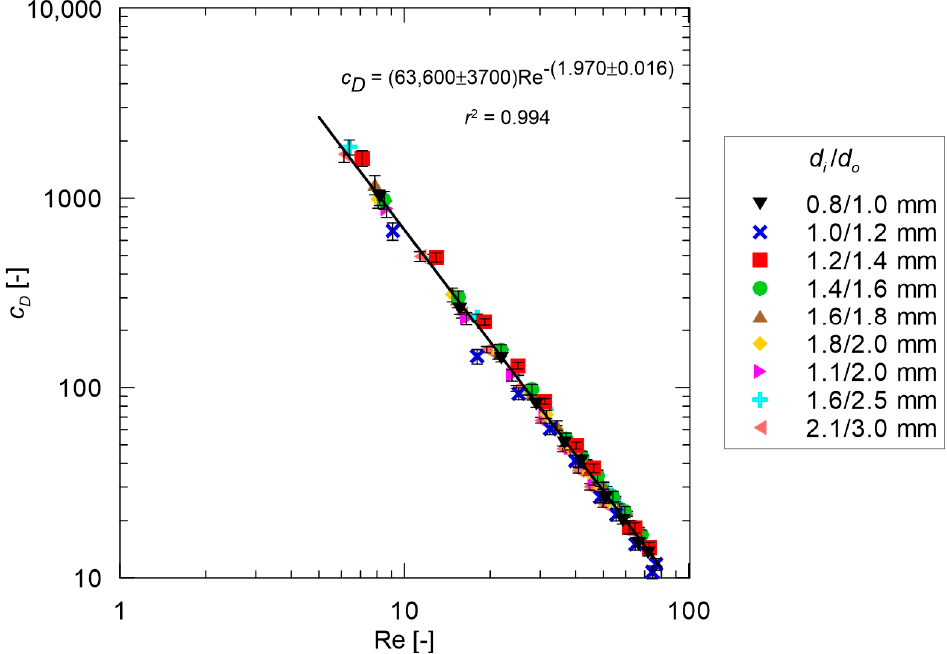
Figure 4. Drag coe ffi cient, c D , (28) versus Reynolds number